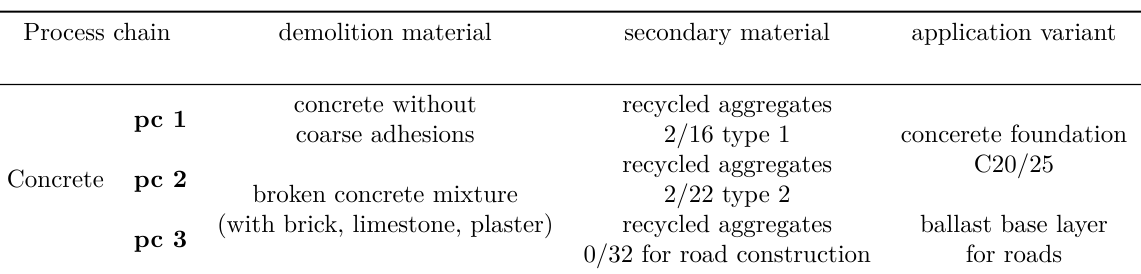
Table 1. Model-like pc for